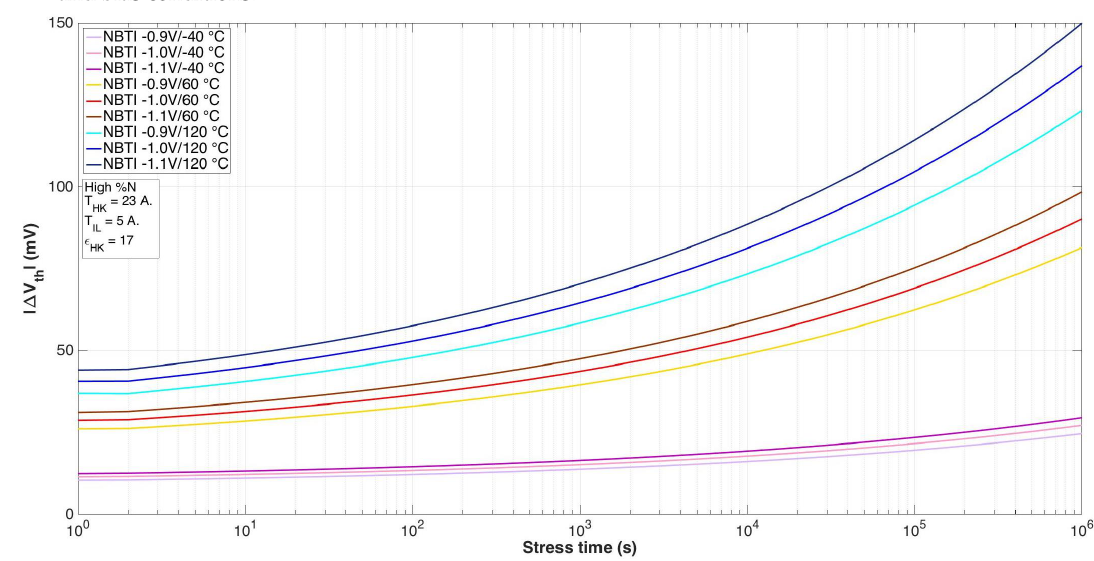
Figure 10. High nitrogen concentration with respect to NBTI evaluation under different temperatures and bias